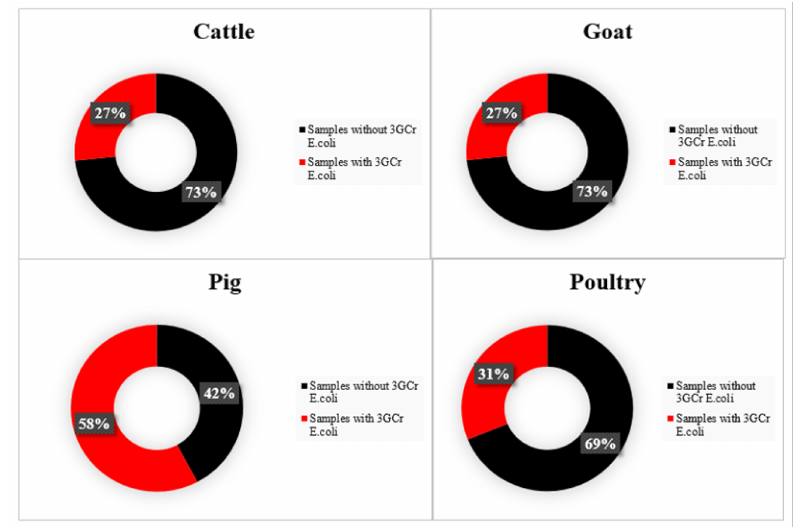
Figure 3. Recovery rates of 3GCr E. coli from cattle, goats, pigs, and poultry fecal samples in the East province of Rwanda. The total number of samples for each animal species was 45. 3GCr: third-generation